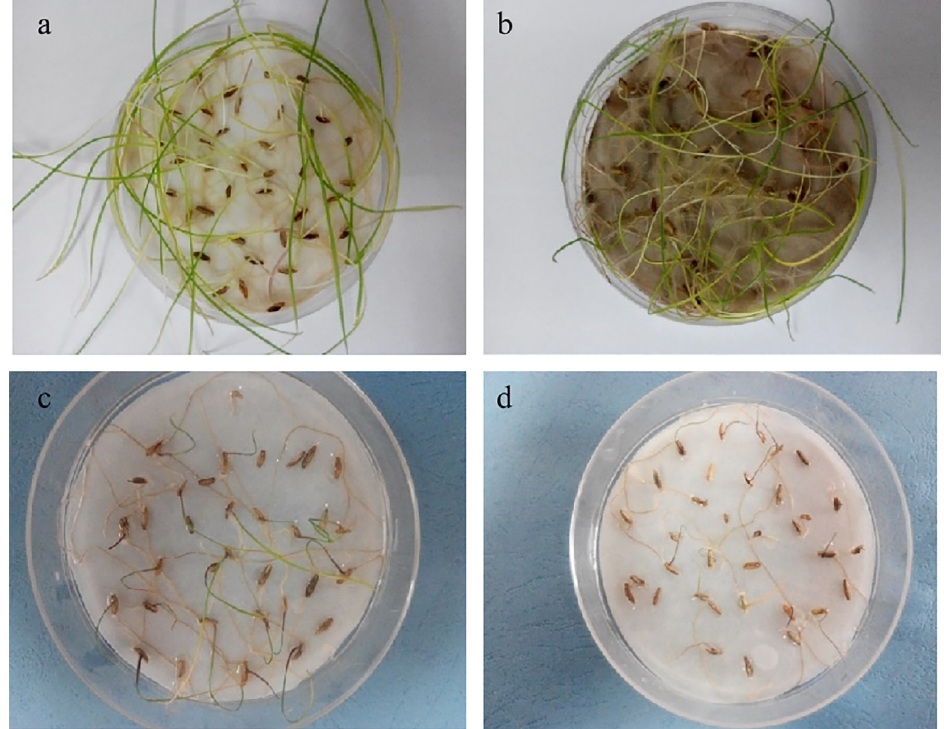
Figure 5. Photo of L. multiflorum growth. DI ( a ); 40 mg/L Ag content Ag@PDS ( b ); 40 mg/L Ag content AgNO 3 ( c ); 40 mg/L Ag content AgNPs ( d ).